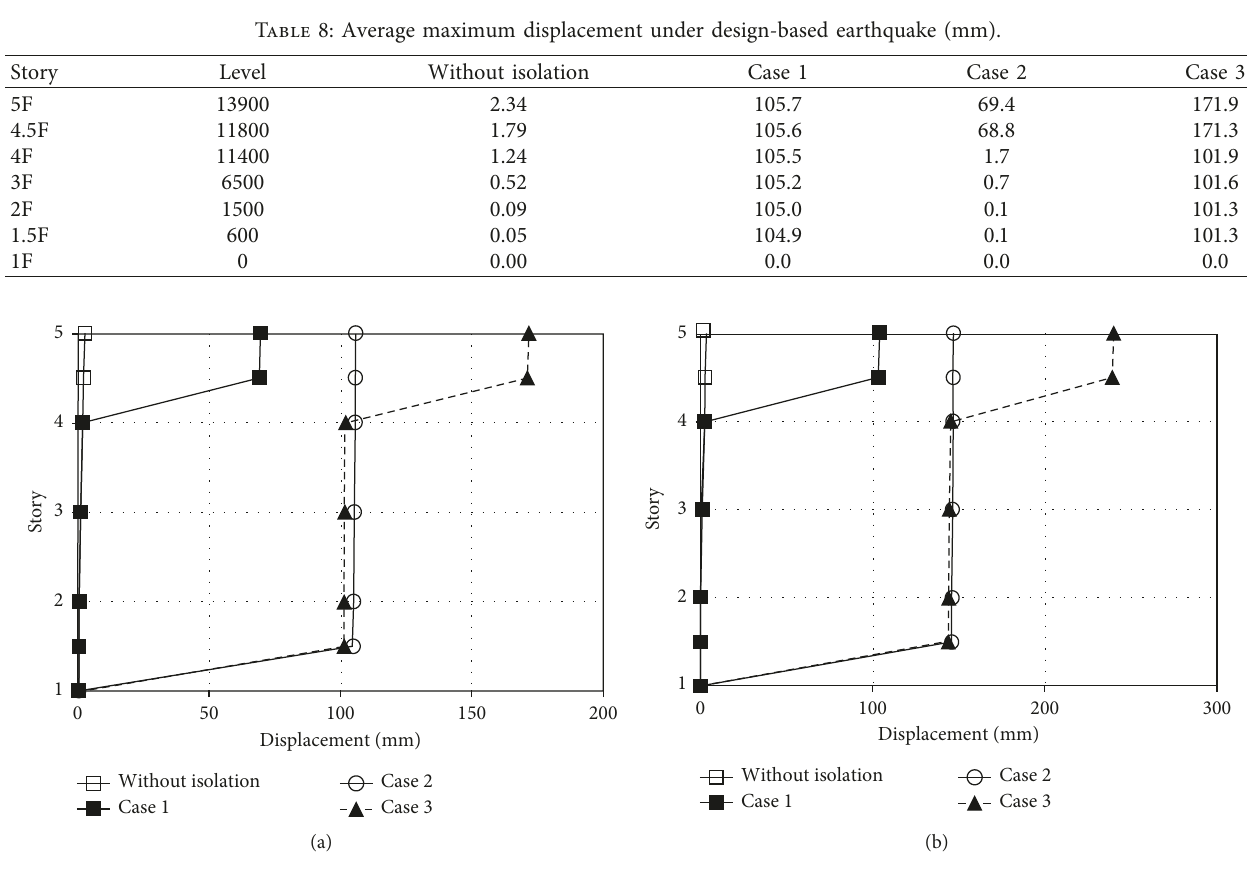
Figure 13: Average maximum displacement result. (a) DBE. (b) MCE. Table 9: Average maximum acceleration under design based earthquake